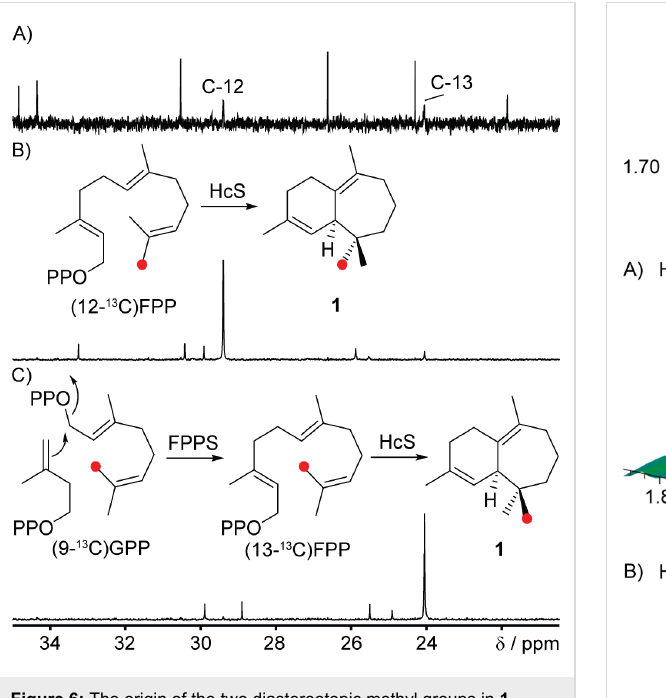
Figure 6: The origin of the two diastereotopic methyl groups in 1 . Partial 13 C NMR spectrum of A) unlabelled 1 , B) an extract obtained from the incubation of HcS with (12- 13 C)FPP and C) an extract ob- tained from the incubation of HcS with (9- 13 C)GPP, which is enzymati- cally converted to (13- 13 C)FPP. Red dots indicate 13 C labelled carbon atoms.